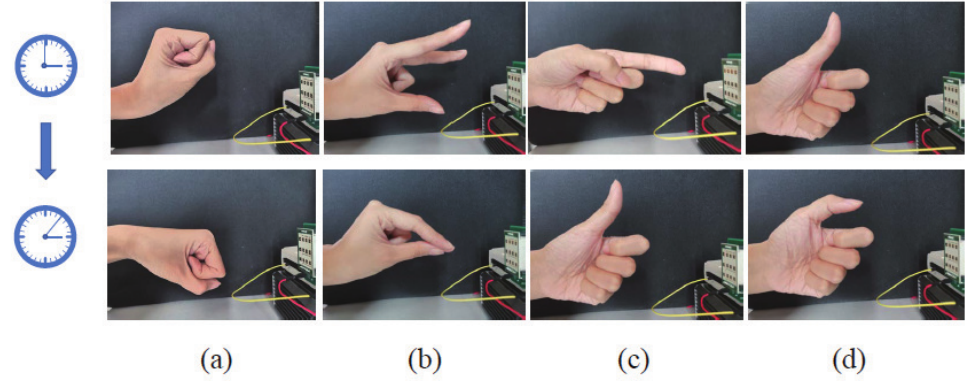
Figure 6. Four signs measured: ( a ) “Yes” in ASL, ( b ) “No” in ASL, ( c ) “Hello” in CSL, ( d ) “Thanks” in CSL.